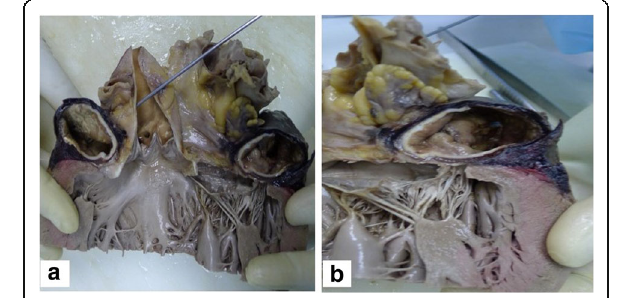
Fig. 4 Aneurysmal dilatation of the left main coronary artery, extending to proximal left circumflex coronary artery. A probe was inserted from the left coronary ostium into the left main coronary artery. a View upon opening of the aortic valve. b Closer view of the ruptured